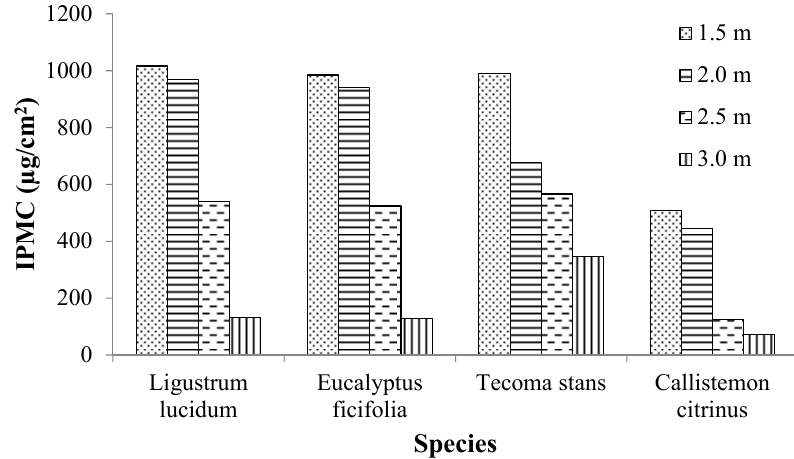
Figure 4. IPMC variations with respect to the sampling height in Zone 1 species.